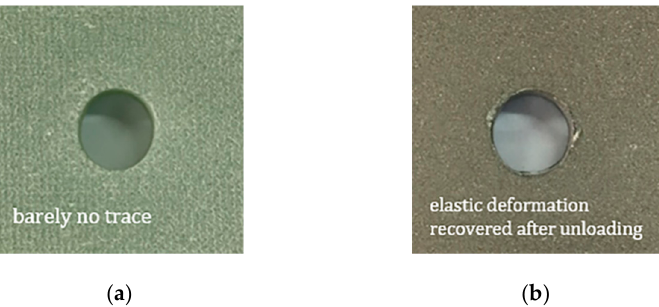
Figure 8. Plate surfaces of G-S24# connection after shear test. ( a ) GFRP connecting plate surface after shear test;